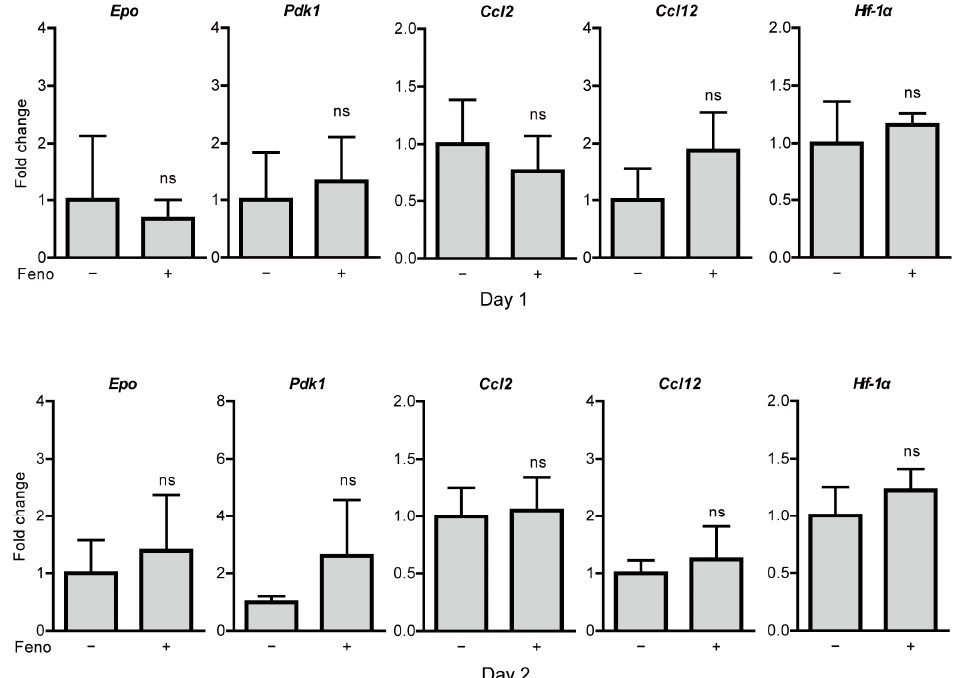
Figure A7. No change in retinal hypoxia-responsive gene expressions by oral administration of fenofibrate in the UCCAO-operated mice. Quantitative analyses ( n = 4 per group, upper) show that oral administration of fenofibrate did not change expressions of Epo , Pdk1 , Ccl2, Ccl12, and Hif-1 α in the retina 1 day after UCCAO. Quantitative analyses ( n = 5–7 per group, lower) show that oral administration of fenofibrate did not change expressions of Epo , Pdk1 , Ccl2 , Ccl12 and Hif-1 α in the retina 2 days after UCCAO. p > 0.05. The data were analyzed using Student’s t -test (two-tailed), and presented as mean ± standard deviation. UCCAO; unilateral common carotid artery